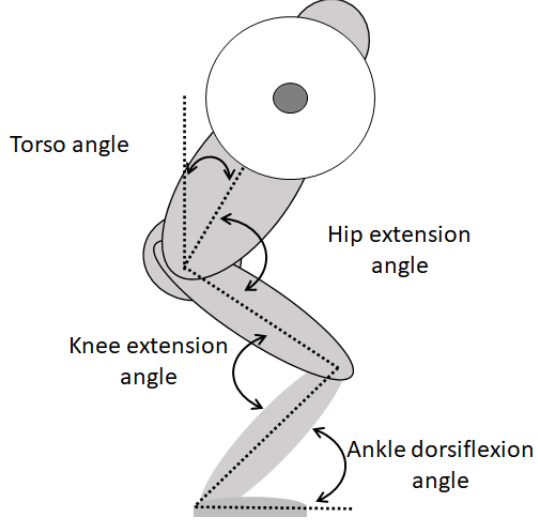
Figure 1. Different joint angles during a back squat.